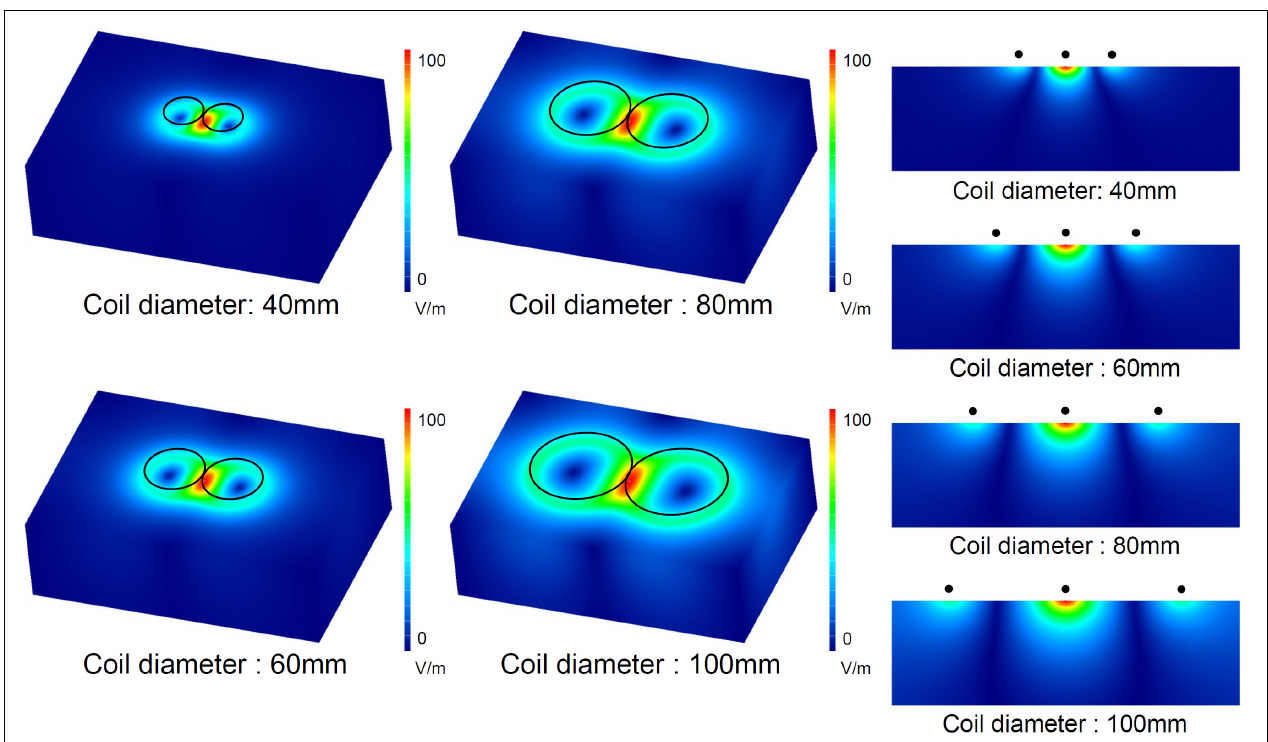
FIGURE 2 | Numerical simulation of electric fields induced by figure-eight coils with four different diameters. The electric current in the coil was 1 kA for the four diameters.